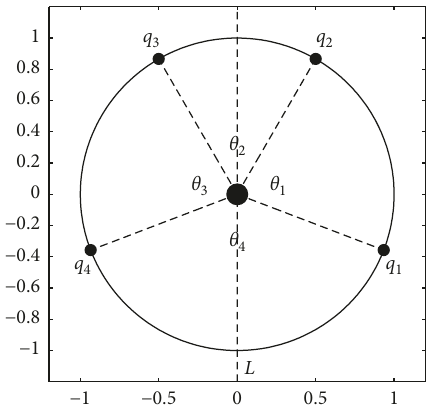
+ μ ) / ( μ + μ ) , and , θ , ( μ 1 2 1 4 2 3